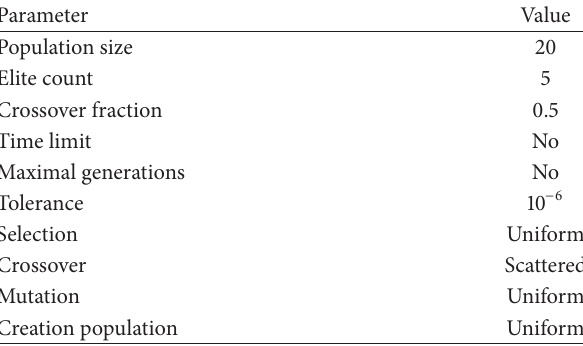
Table 2: Genetic algorithm configuration.